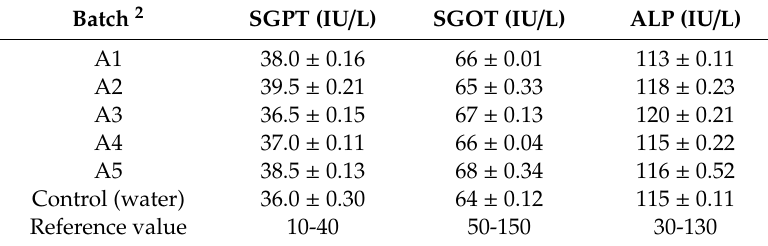
Table 3. Toxicology study via liver function test (LFT) 1 .